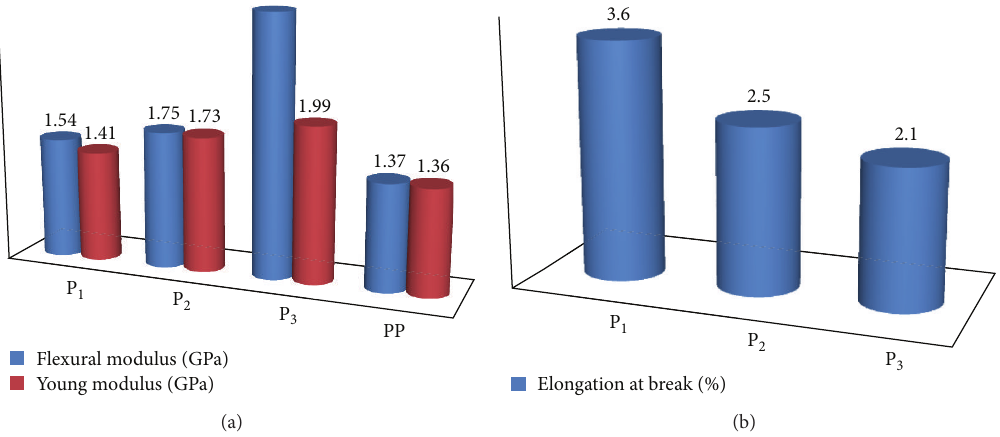
Figure 1: Young’s modulus and flexural modulus (a) and elongation of break (b).